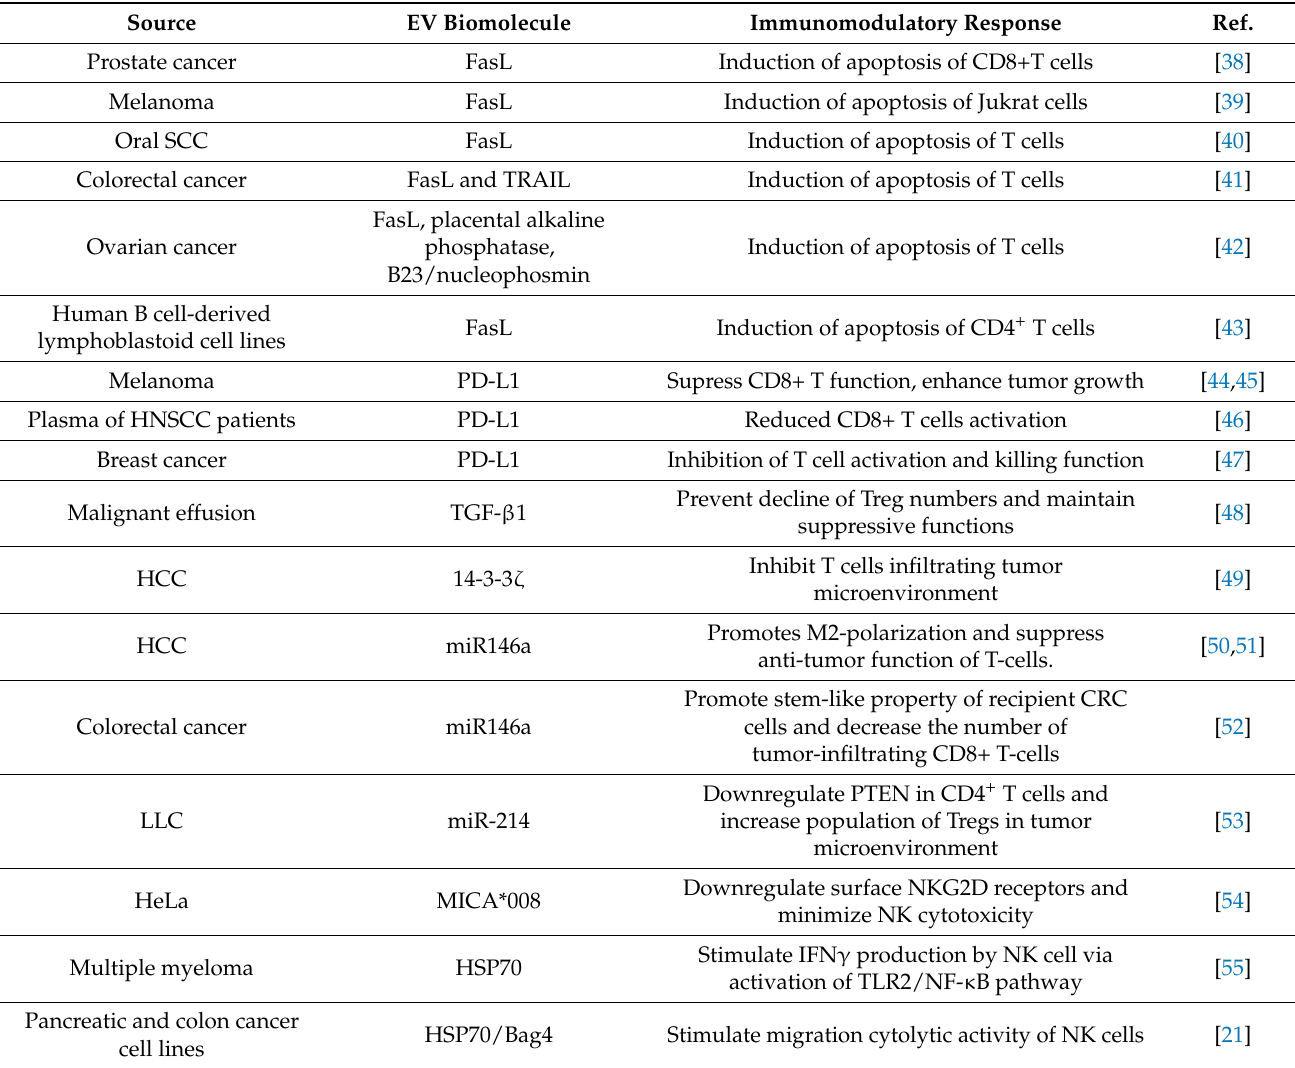
Table 1. Biomolecular components of EVs/exosomes for